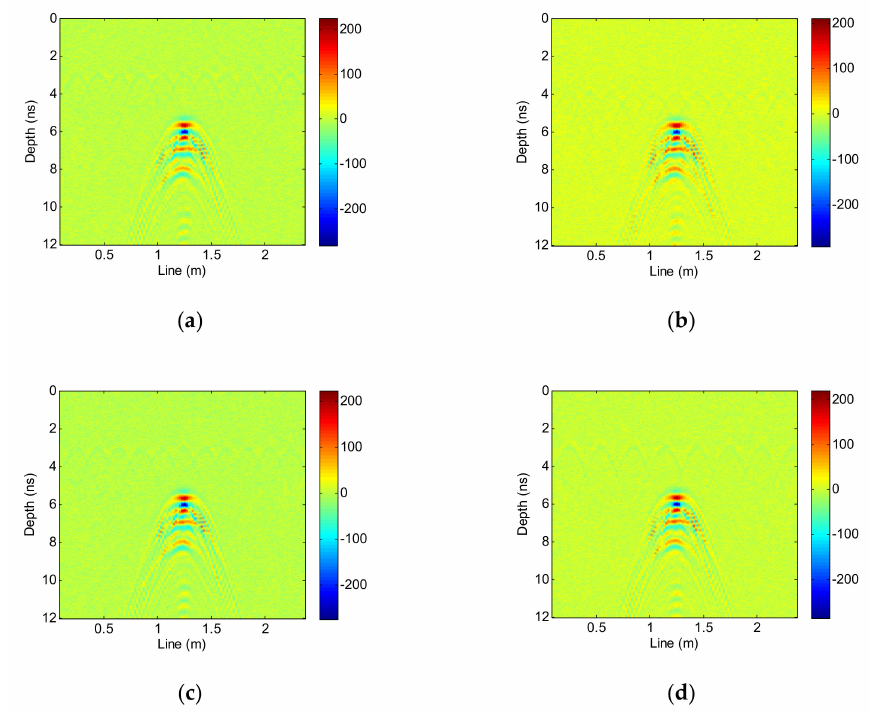
Figure 13. Output results of the trained network. ( a ) Depth of 10, spacing of 20, and radius of 1.25. ( b ) Depth of 15, spacing of 20, and radius of 1.25. ( c ) Depth of 10, spacing of 20, and radius of 1. ( d ) Depth of 10, spacing of 30, and radius of